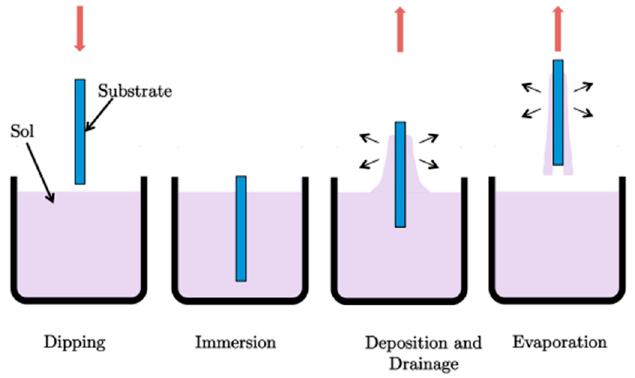
Figure 4. Deposition by the dip-coating technique: dipping and immersion of the substrate into the sol, formation of the layer by withdrawing the substrate and gelation of the layer by solvent evaporation.